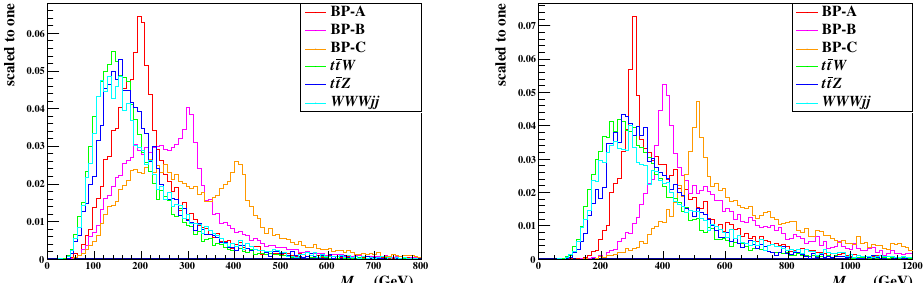
Figure 11 . Left (right): reconstruction of N R ( H (cid:6) ) via invariant mass M LHC for the SSD